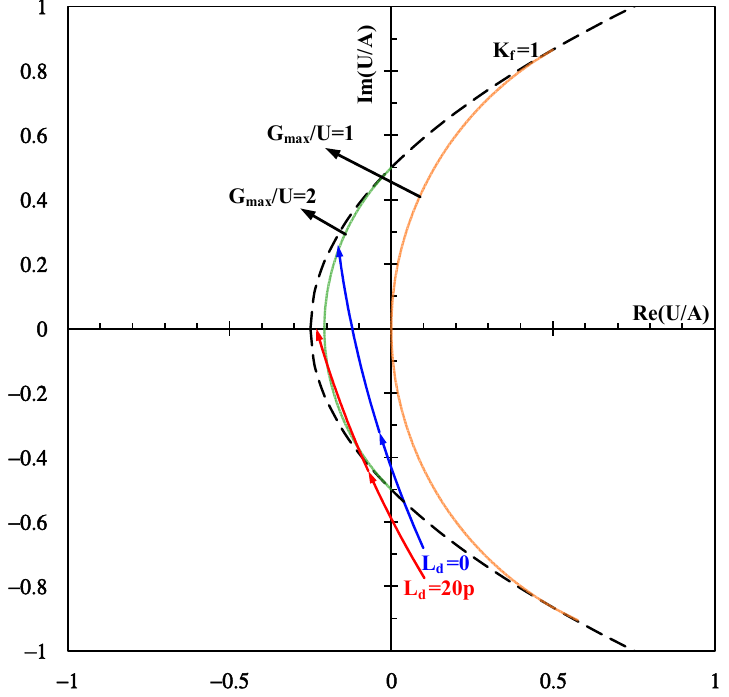
Figure 3. Location movements with the increased neutralization capacitances with and without L d , respectively.